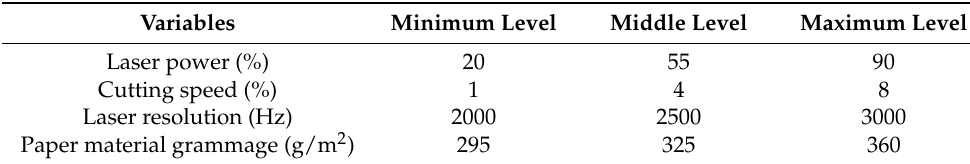
Table 2. Independent process variables with experimental levels. Variables Minimum Level Middle